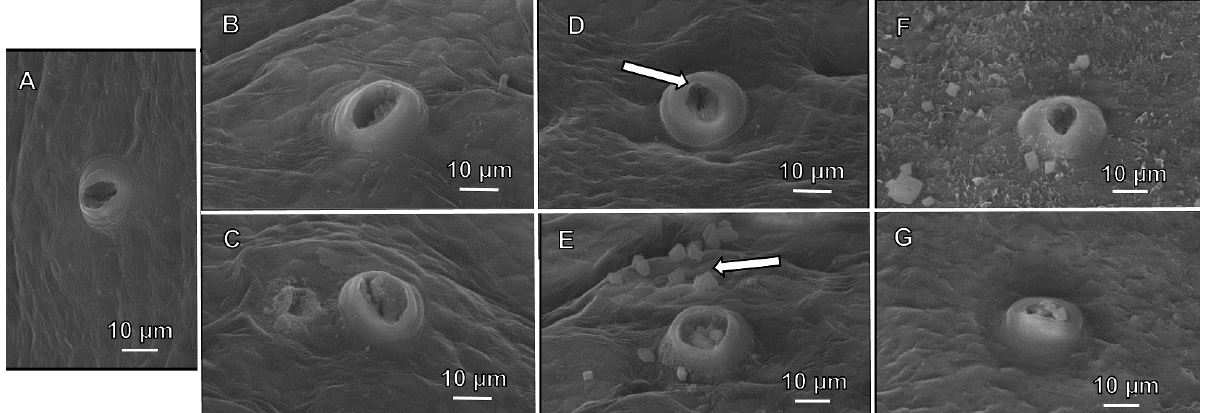
Figure 2. Scanning electron micrographs of stomata and the cuticle of orange fruits 30 ( A ), 44 ( B , C ), 66 ( D , E ), and 99 ( F , G ) days after full bloom (DAFB), showing healthy ( A , B , D , F ) and collapsed ( C , F , G ) stomata. Guard cells are distinguishable at 66 DAFB (arrow in D ), scattered crystalized waxes (arrow in E ) are also visible.